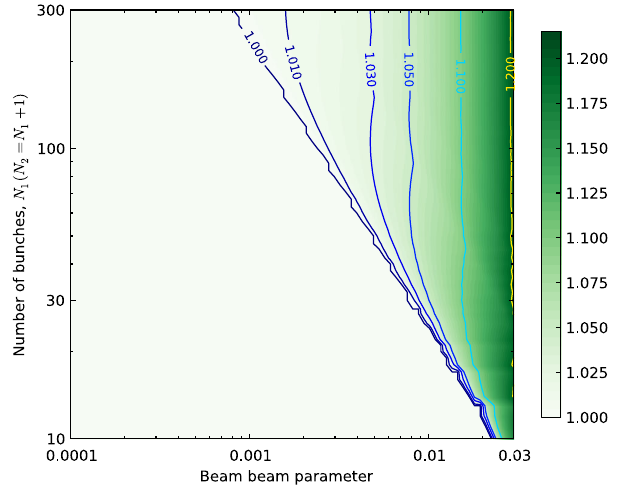
FIG. 2. The largest module of the eigenvalues of M T for different beam-beam parameters and number of bunch in ring one N 1 , while N 2 ¼ N 1 þ 1 . Both tunes in two rings are optimized around 0.2 for each N 1